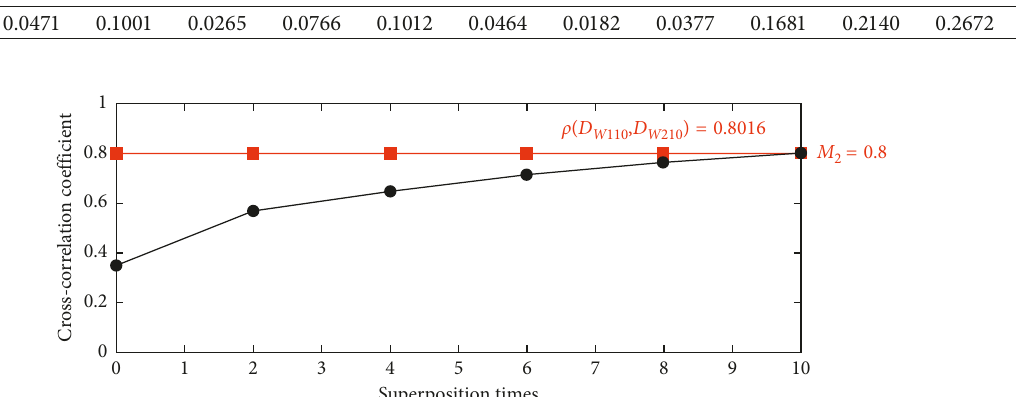
Figure 20: ρ ( D W 1 k , D W 2 k ) under 1–10 numbers of superposition. ρ ( D W 10 , D W 20 ) represents ρ ( W 1 , W 2 ).